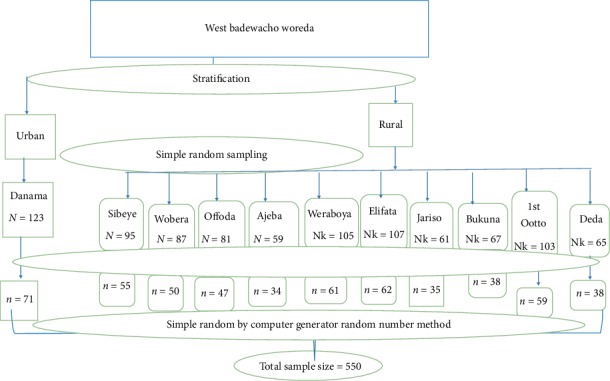
Schematic presentation of sampling procedure of randomly selected kebeles of West Badewacho Woreda, 2018.